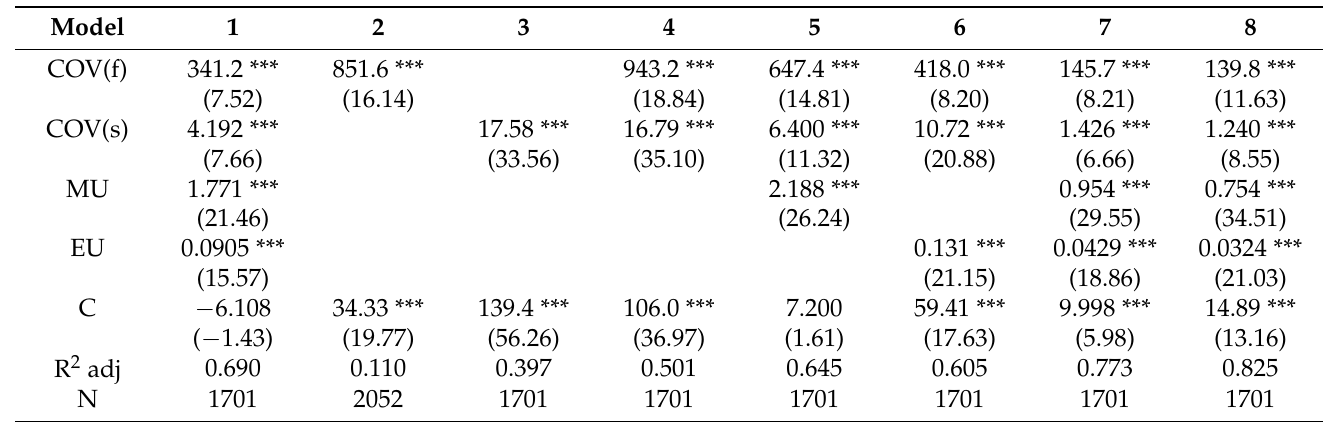
Table 2. COVID-19 death announcements and oil price volatility, panel world